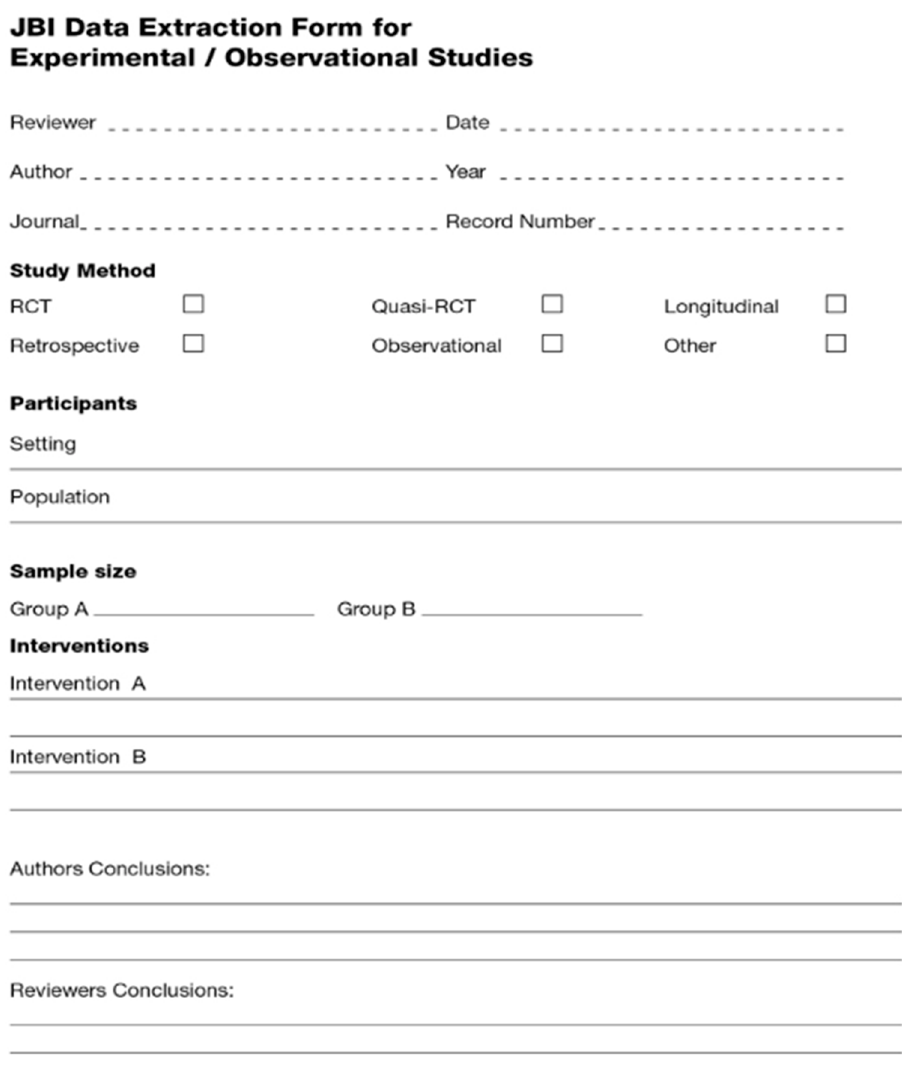
Figure A5. JBI Data Extraction Form for Experimental / Observational